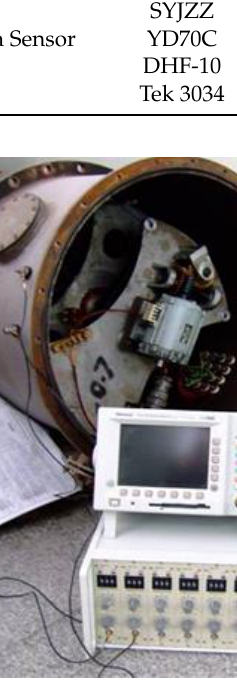
Figure 3. Vibration test in the laboratory.